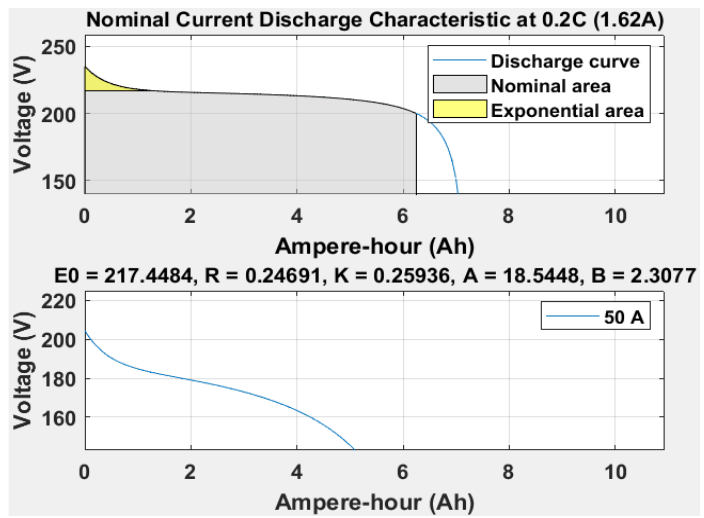
Figure 12. Characteristics of discharge current.